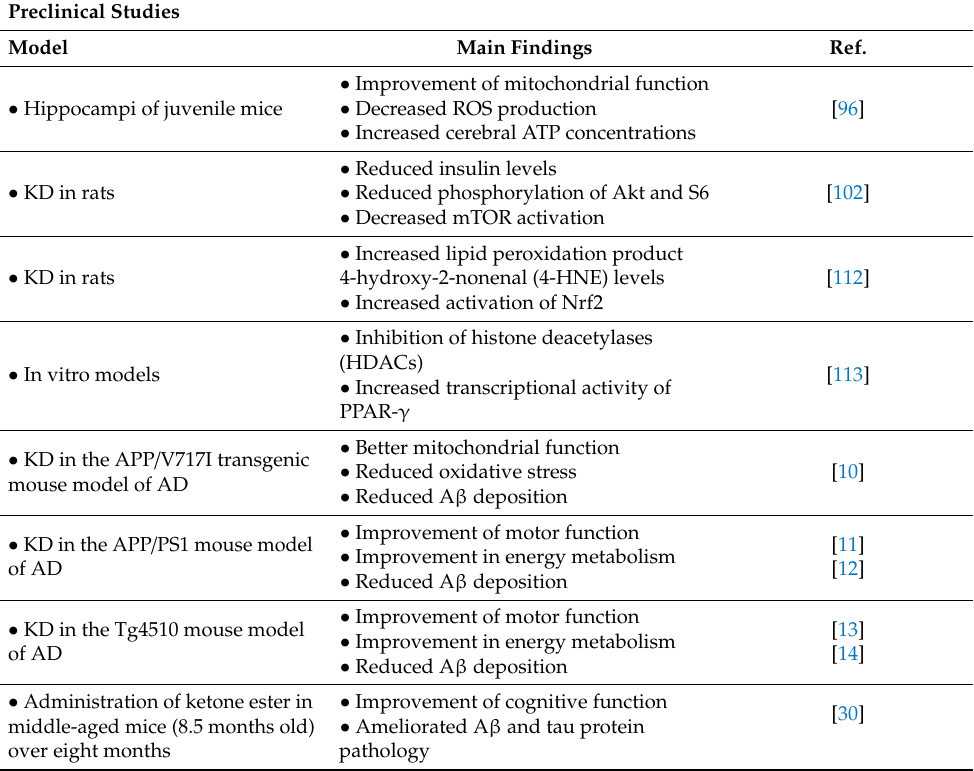
Table 1. Main preclinical evaluations of KD treatment in